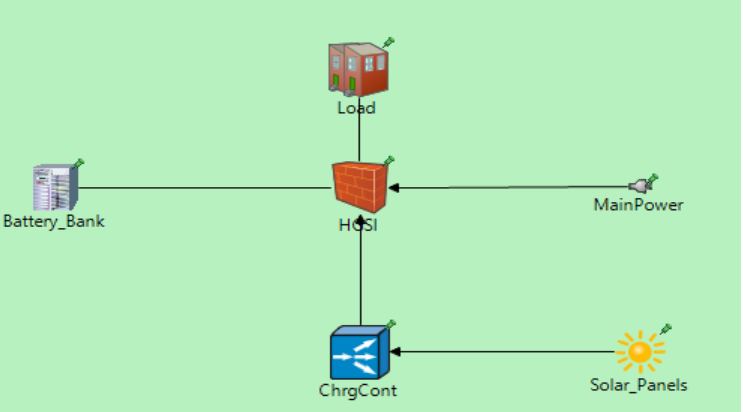
Figure 6. Nanogrid simulation setup in OMNET++.